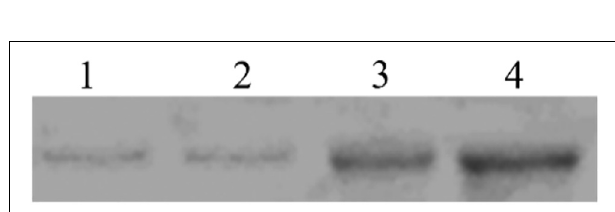
FIGURE 7 | Determination of saturated binding between biotinylated Sip toxin and C. bowringi BBMV. 1–4: 25, 50, 75, and 100 nM biotinylated Sip, respectively.